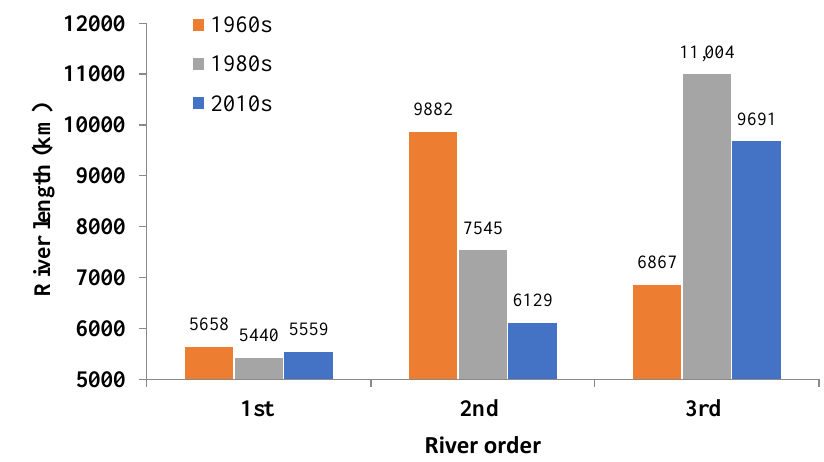
Figure 4. River systems changed in length at each time.